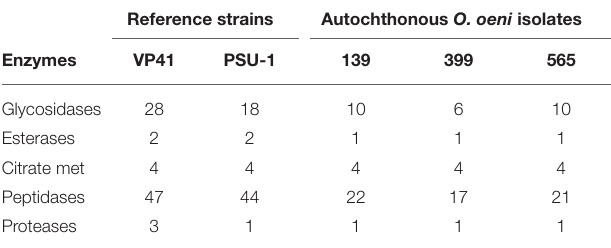
This study covered an extensive Chilean enological region from 30 ◦ 39 ′ S to 35 ◦ 50 ′ S latitude and analyzed the total and lactic acid bacterial loads using culture-independent methodology.